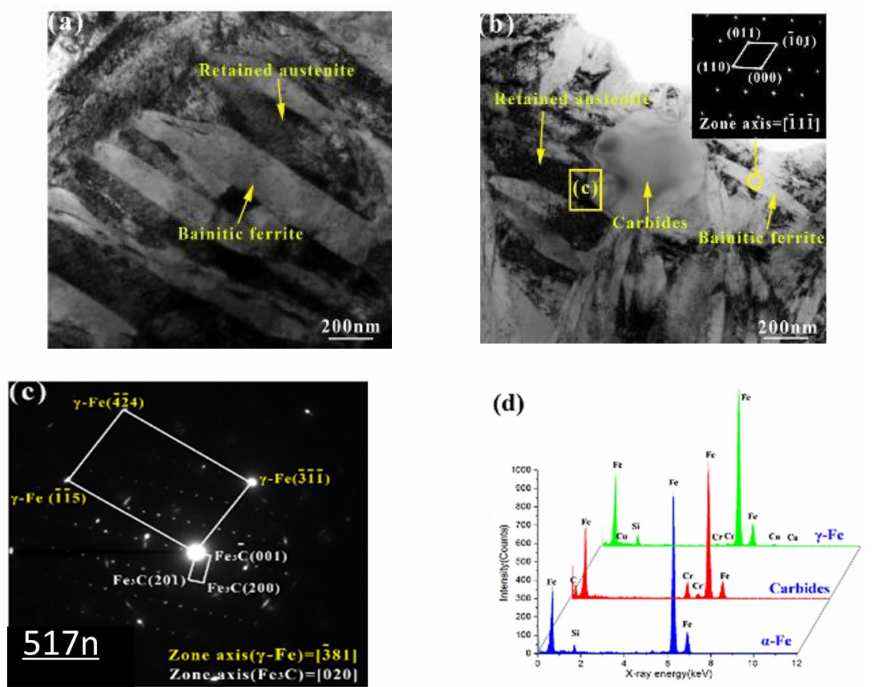
Figure 13. Further morphological structures of Cu-bearing carbidic austempered ductile iron through TEM: ( a ) Cu-free CADI; ( b ) CADI with 2.0 wt.% Cu; ( c ) selected area diffraction patterns (SADPs) of area C in Panel ( b ); ( d ) EDX outcome for three phases [40].